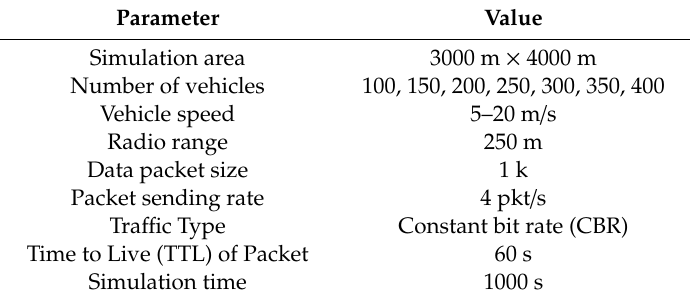
Figure 6. Simulation city roadways ( a ) and intersection structure ( b ) . Table 5. Simulation parameter.